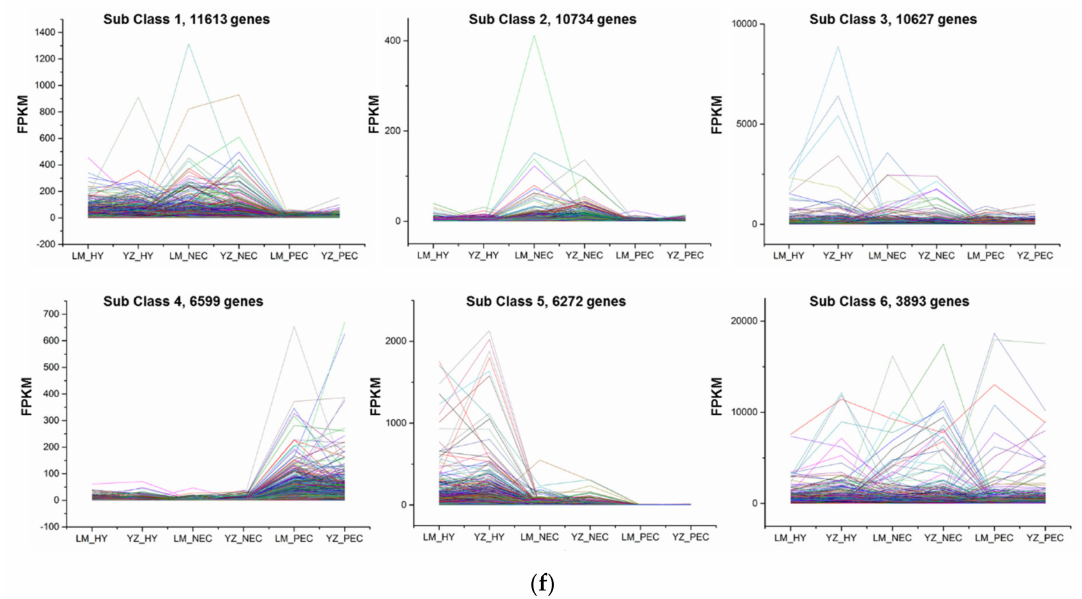
Figure 2. Analysis of di ff erentially expressed genes in di ff erent developmental stages during cotton SE. ( a ) Identified di ff erentially expressed genes (DEGs) during callus dedi ff erentiation and embryogenic callus transdi ff erentiation periods; ( b ) Volcano map of DEGs during callus dedi ff erentiation in LM; ( c ) Volcano map of DEGs during callus dedi ff erentiation in YZ; ( d ) Volcano map of DEGs during embryogenic callus transdi ff erentiation in LM; ( e ) Volcano map of DEGs during embryogenic callus transdi ff erentiation in YZ; ( f ) K-means clustering of DEGs in di ff erent developmental stages during early SE in LM and YZ. Colored lines indicate changes in gene expression